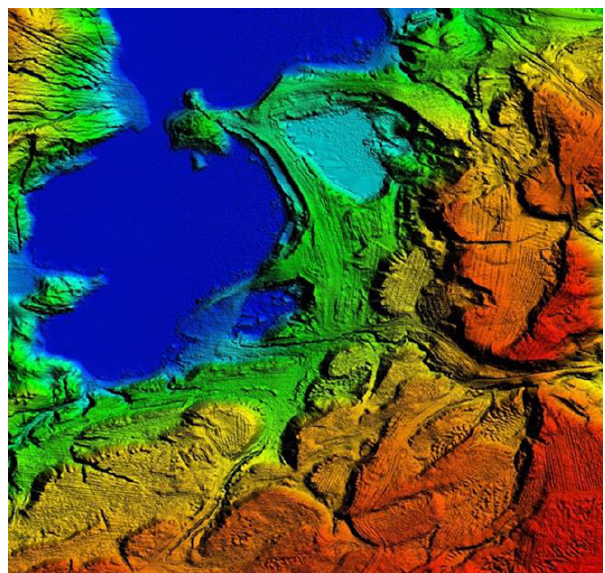
Figure 2. LIDAR DEM with 0.25 m resolution of the study